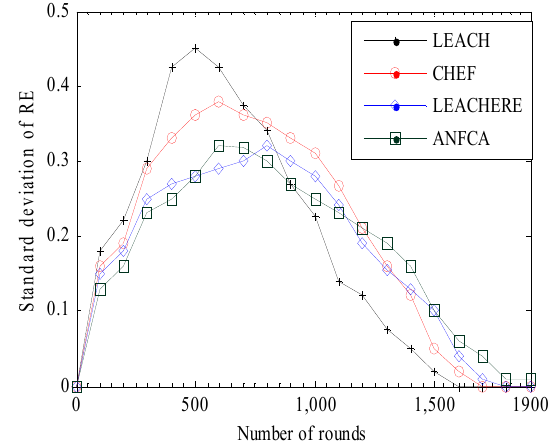
Figure 11. Standard deviation over rounds.